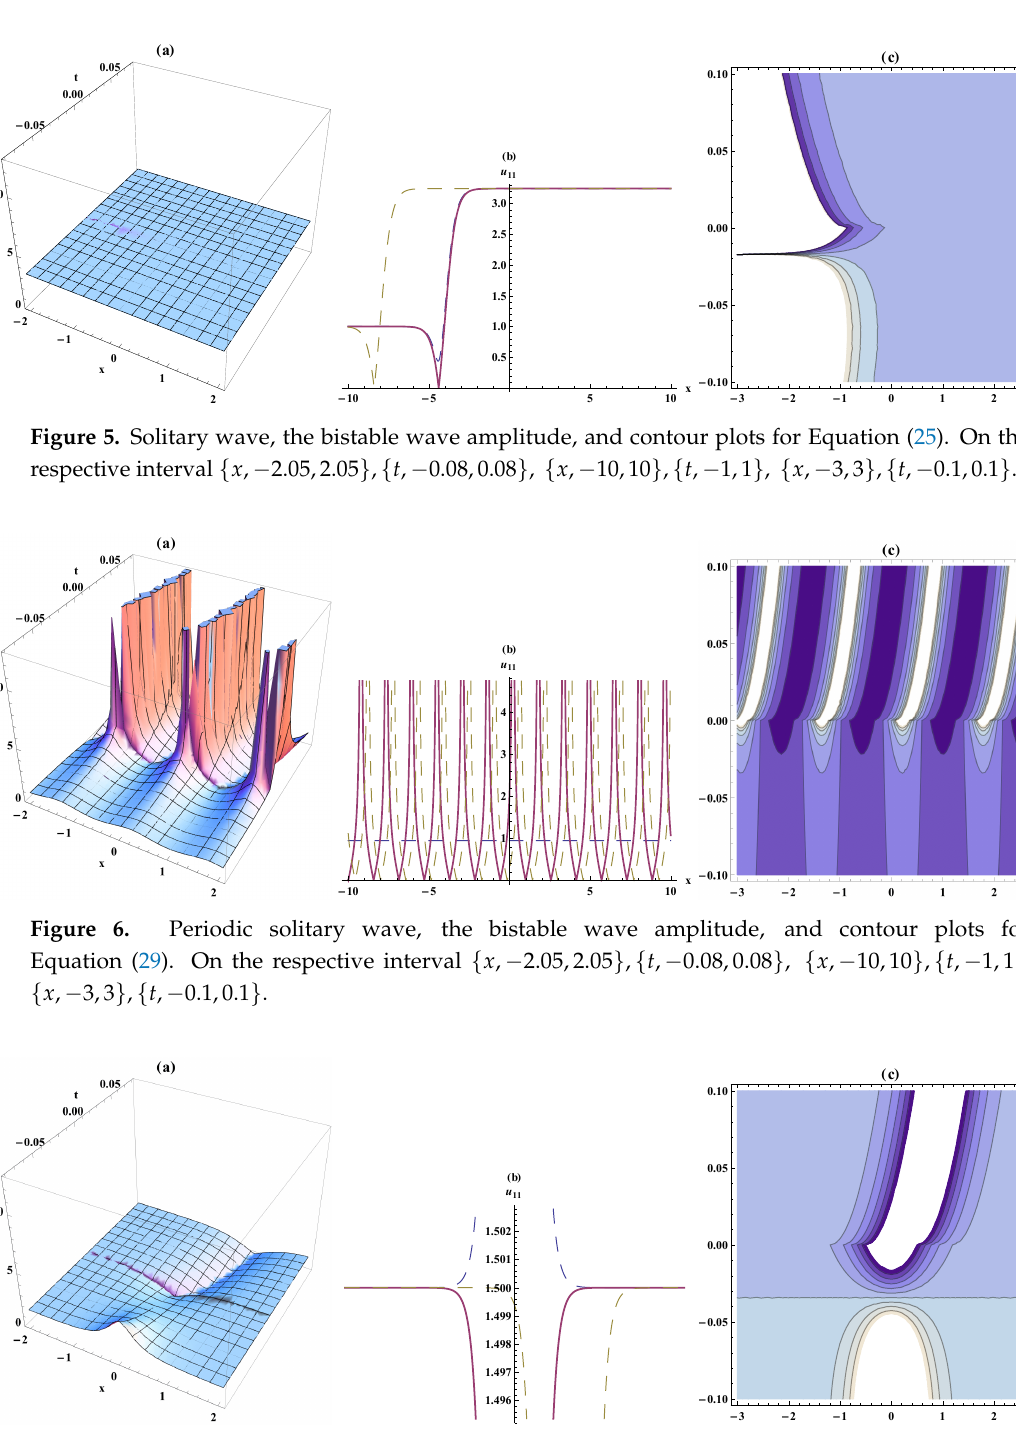
Figure 7. Solitary wave, the bistable wave amplitude, and contour plots for Equation (50). On the respective interval { x , − 2.05,2.05 } , { t , − 0.08,0.08 } , { x , − 10,10 } , { t , − 1,1 } , { x , − 3,3 } , { t , − 0.1,0.1 }